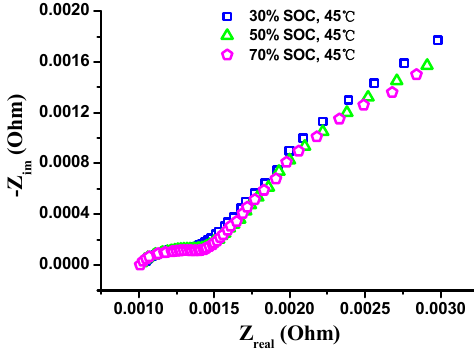
Figure 14. EIS curves at different SOCs when the test temperature is 23 °C.